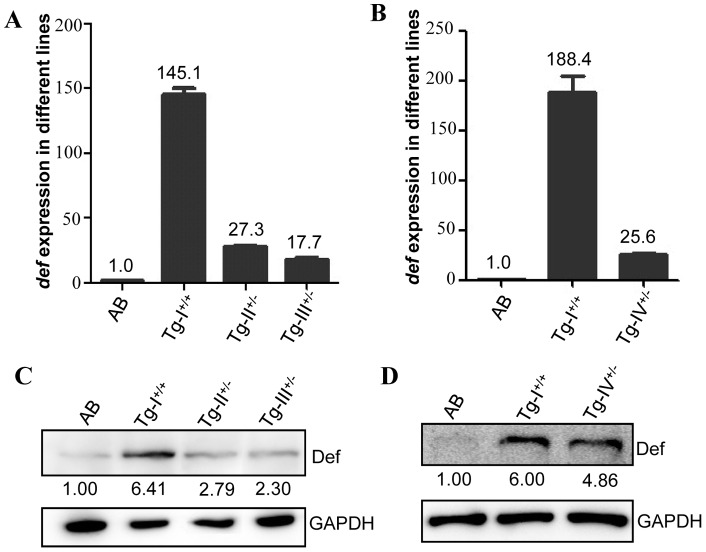
Levels of def transcripts and Def protein in the adult liver of Tg-I, Tg-II, Tg-III and Tg-IV.(A–D) The def transcript levels in Tg-I, Tg-II and Tg-III (A) or in Tg-I and Tg-IV (B) were determined by qPCR and Def protein levels by western blotting using an anti-Def monoclonal antibody (C and D). Interestingly, while the transcriptional expression of def showed a great range of difference in different genetic background (145, 27, 18 and 26 folds higher in Tg-I, Tg-II, Tg-III and Tg-IV, respectively, than in the WT) (A and B) the protein levels in these three lines did not differ in a corresponding scale (6.4, 2.8, 2.3 and 4.9 folds higher in Tg-I, Tg-II, Tg-III and Tg-IV, respectively, than in the WT) (C and D).